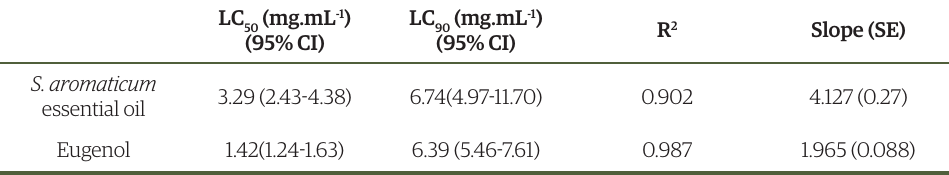
Probit analyses were performed for all data using IBM SPSS Statistics software (version 26.0 April, 2019); LC (mg. mL-1) (95% CI): 50% lethal concentration values followed with their 95% confidence interval; LC (95% CI): 90% lethal concentration values followed with their 95% confidence interval; R: Pearson correlation coefficient; Slope (SE): slope of the concentration curve and Standard